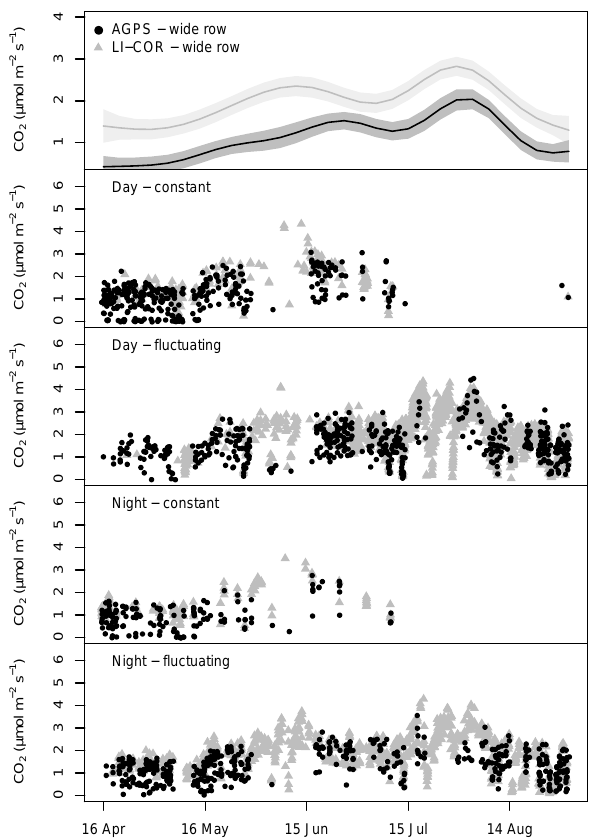
Figure 4. Unfiltered chamber CO 2 flux data sets for the entire monitoring period (wide rows only). The top panel shows the av- erage daily CO 2 flux and its respective 95% confidence interval for each chamber system estimated using generalized additive mod- els (GAM) (deviance explained: AGPS 64.9%, n = 896; LI-8100A 58.6%, n = 527). In the other panels, the single measured CO 2 fluxes over time were grouped by time of the day and stability of the atmospheric CO 2 concentration at 50cm above the soil surface. The data sets were divided into day and night based on sunrise and sunset times. Atmospheric CO 2 concentration was considered as constant when the standard deviation for a 3min measurement prior to the chamber closures was ≤ 1.0 ppm. The AGPS CO 2 fluxes were calculated from the first 4min of the closure time (including 1min deadband).